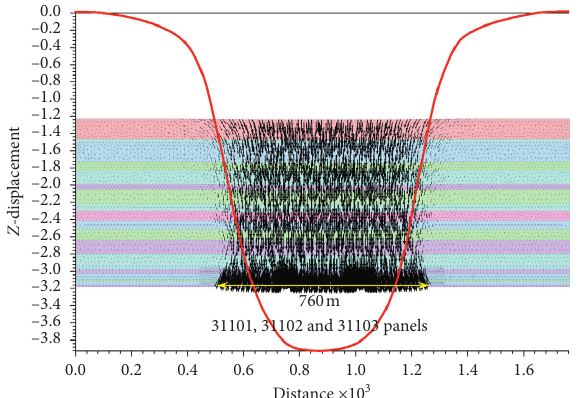
Figure 19: Subsidence of 31101, 31102, and 31103 panels. Strain Inc. Scale: 4859.27 Minimum prin.